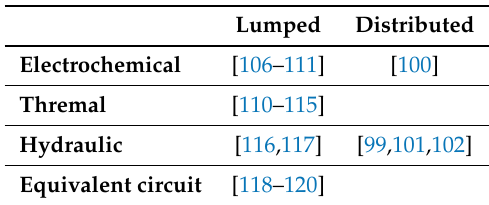
Table 6. RFB mathematical models